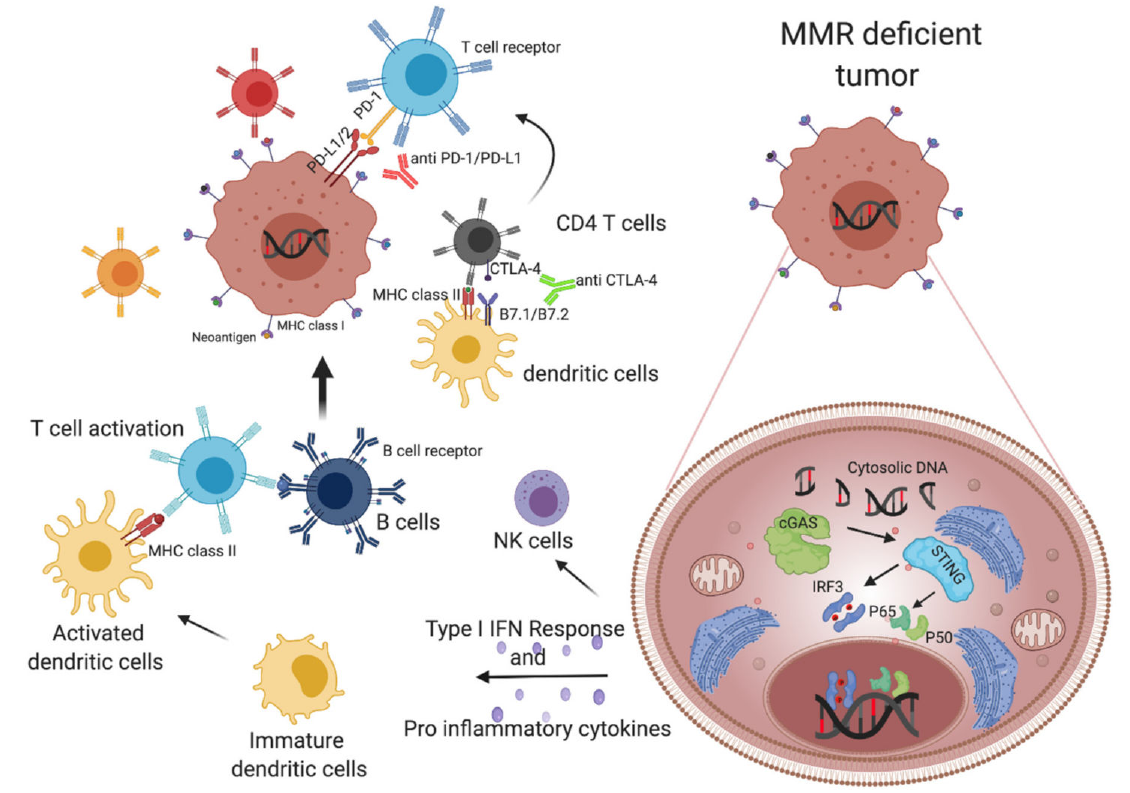
Figure 2. Cytosolic DNA and cGas-STING pathway activation lead to a strong immune response triggered by an antigen- and INF-mediated activation of adaptive immune compartments. The contribution of neoantigens to tumor regression of MSI tumors upon CPIs is a matter of fact. However, recent findings demonstrated that cytosolic DNA accumulation occurs in MSI cancer cells [87]. As consequence of this biochemical process, the cGAS-STING pathway is activated, resulting in the induction of type I INF mediated response and leading to the secretion of pro-inflammatory cytokines that sustain and foster anti-tumor response through multiple mechanisms. These findings lead to emergent strategies to trigger an immune response and to enroll patients with a positive predictive response to CPIs (PD-1/PD-L1 and CTLA-4). Created with